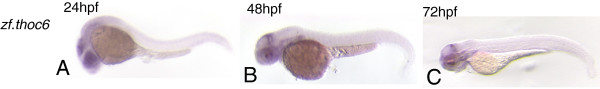
Expression of zebrafish thoc6 in the brain. Expression of zebrafish thoc6 was assessed by whole mount in situ hybridization. Side views of whole mount thoc6 expression observed in 24, 48 and 72 hpf WT embryos. thoc6 is highly expressed in the developing optic tectum and the eyes at 24 hpf (A). This expression decreases at 48 (B) and 72 hpf (C) but a low level of expression is observed at the midbrain-hindbrain boundary.